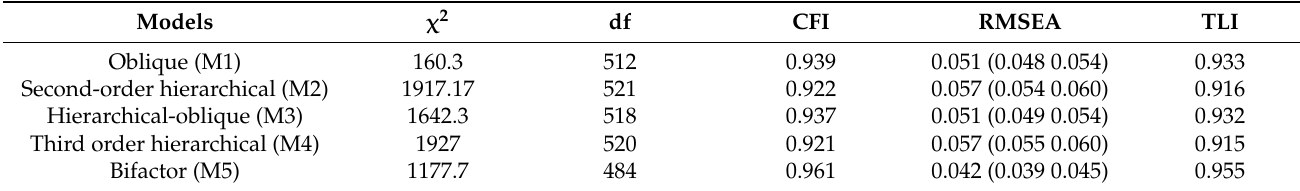
Table 3. Fit indices of models subjected to confirmatory factor analysis